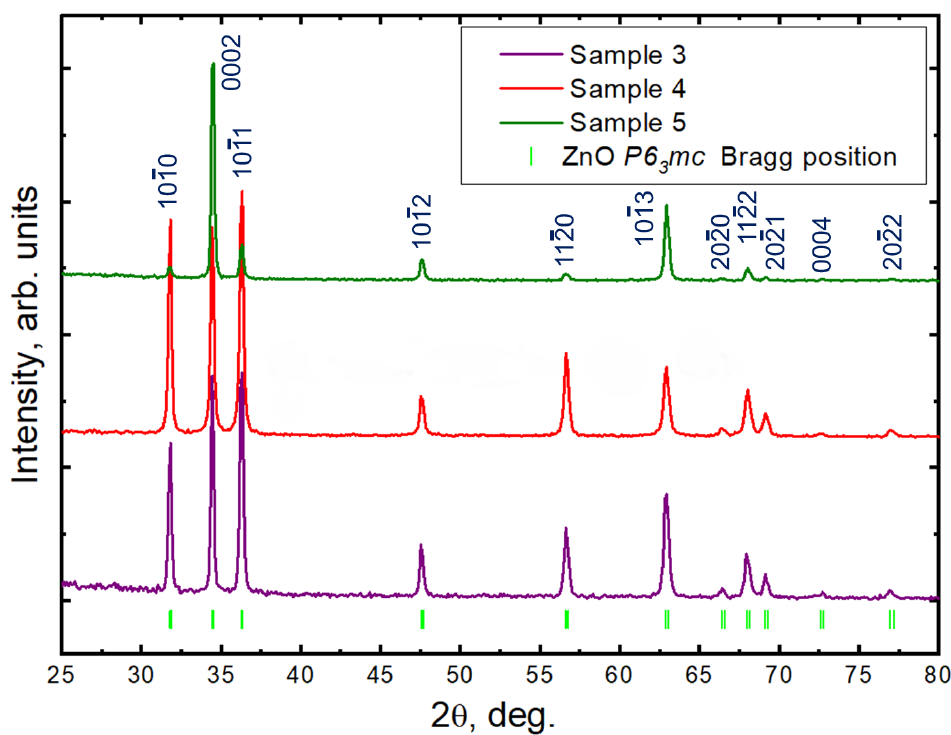
Figure 3. Normalized over the maximum intensity value of powder GIXRD intensity patterns of the studied samples. The patterns are shifted vertically to enhance the visual appeal.